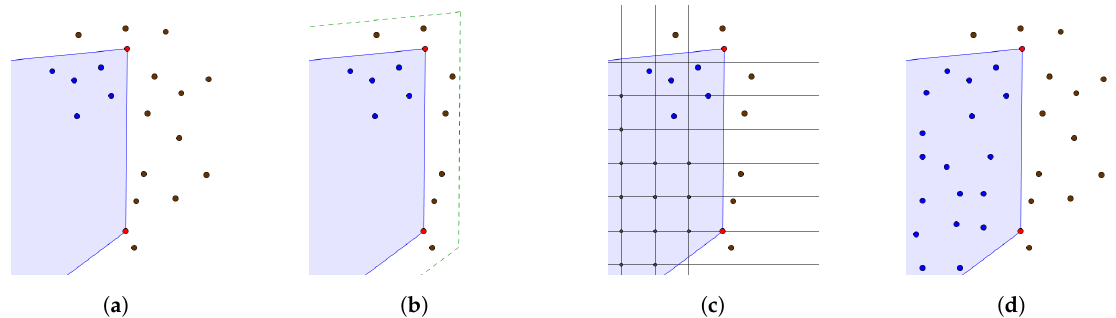
Figure 4. The process of adding points to water surfaces: ( a ) placing polygon data into the point-cloud dataset, ( b ) selecting points in the polygon vicinity, ( c ) adding grid points within the water polygon, and ( d ) removing points that are closer than 1 m to the original points and randomly shifting the added points, where blue points are within the water surface, red points are on the water surface polygon and brown points are terrain points outside the water surface.